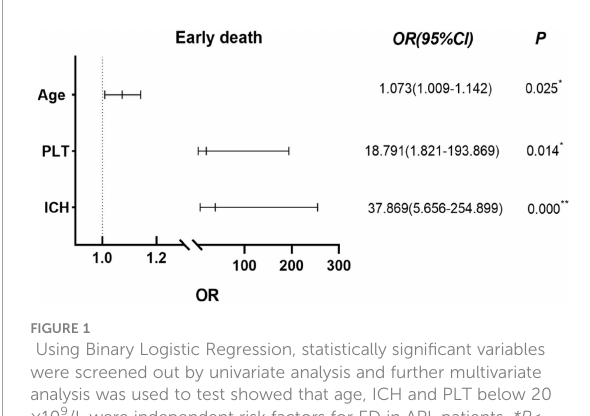
FIGURE 1 Using Binary Logistic Regression, statistically signi fi cant variables were screened out by univariate analysis and further multivariate analysis was used to test showed that age, ICH and PLT below 20 ×10 9 /L were independent risk factors for ED in APL patients. *P < 0.05, **P <